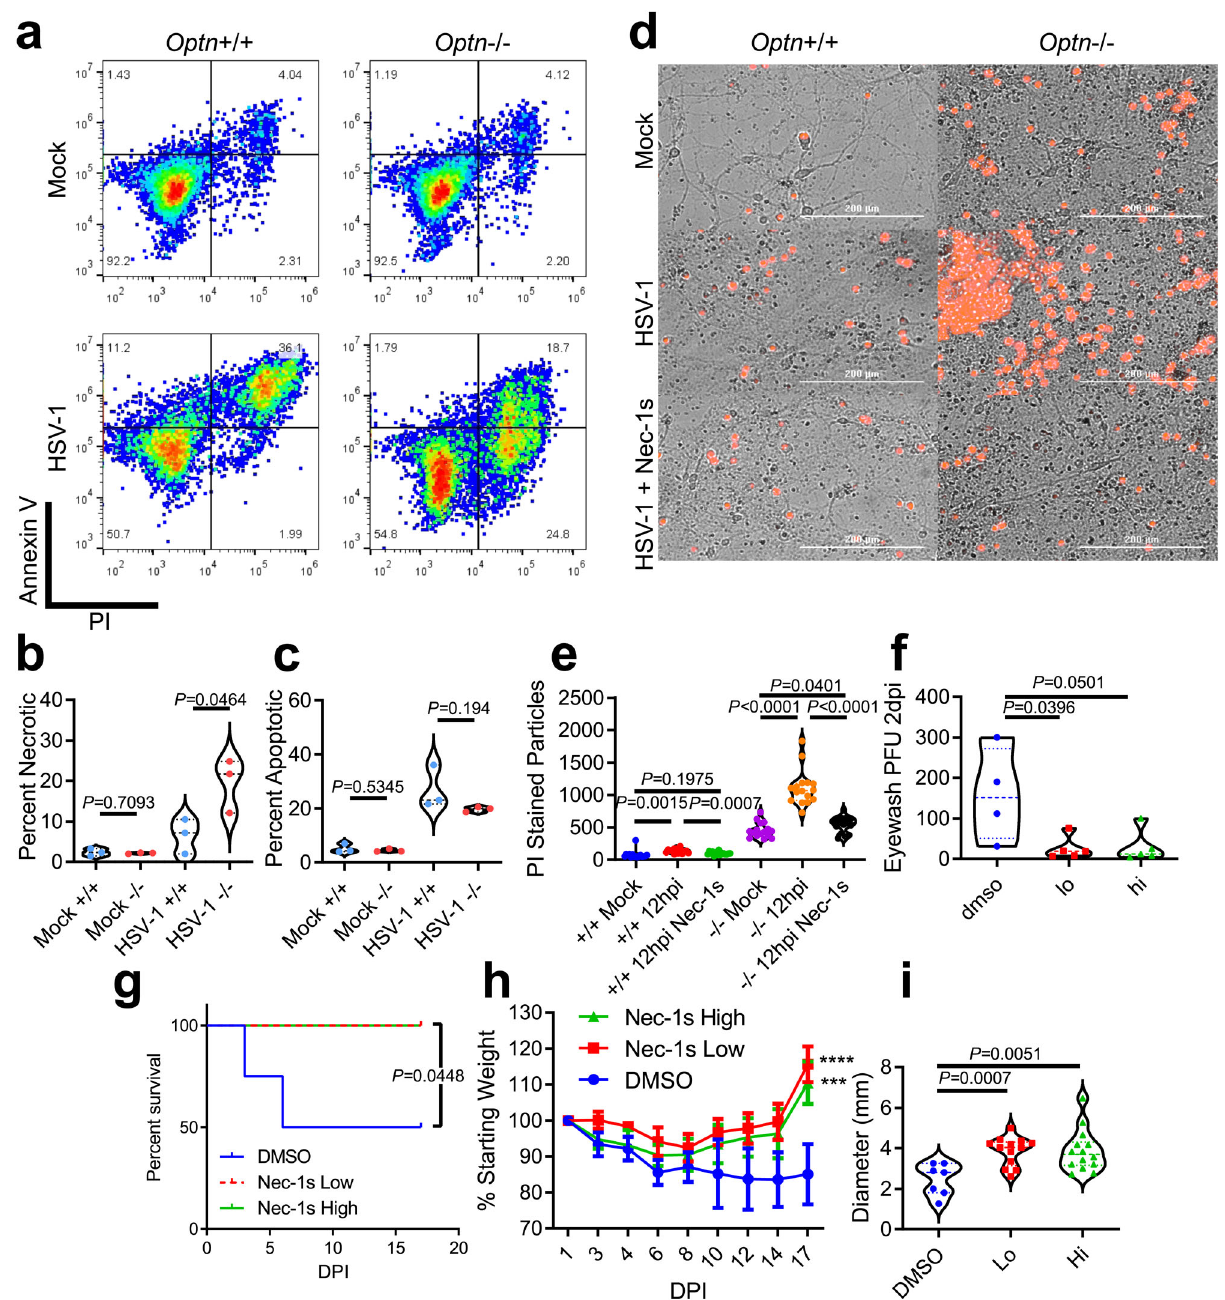
Fig. 7 OPTN suppresses necroptosis in vitro and in neurons during HSV-1 infection. a Dot plots of fl ow cytometry analysis of Optn + / + and − / − cells stained for Annexin V and propidium iodide (PI). b , c Percentage of ( b ) Annexin V lo, PI hi cells indicating necrotic cells or c Annexin V hi, PI hi cells indicating apoptotic cells. d Representative images of primary embryonic neurons from Optn + / + or − / − mice that were mock infected, HSV-1 infected, or HSV-1 infected and Nec-1s treated. Dead cells were stained using PI (Red). e Image quanti fi cation of PI-stained primary neurons. f – i Optn − / − were treated with hi Nec-1s ( n = 5 mice), lo Nec-1s ( n = 5 mice), or DMSO ( n = 4 mice) during infection. f Plaque assay on ocular washes from Optn − / − mice 2 dpi. g Kaplan – Meier curve for HSV-1 infected Optn − / − treated with DMSO, lo or hi Nec-1s. Logrank test for trend was used to compare curves with P < 0.05 being signi fi cant. h Percentage of initial weight over time. Two-way repeated-measures ANOVA F (16,88) = 1.758, p = 0.0503, multiple comparisons at 17 dpi (DMSO vs. Nec-1s Low) p < 0.0001, (DMSO vs. Nec-1s High) p = 0.0009. i dLN diameters for Optn − / − mice treated with DMSO, lo Nec-1s, or hi Nec- 1s at 17dpi and data are presented as mean values ± SEM. Unless otherwise stated Two-tailed Student ’ s t test was performed for statistical analysis ( α = 0.05). ∗ p < 0.05; ∗∗ p < 0.01; ∗∗∗ p < 0.001, ∗∗∗∗ p < 0.0001, ns not signi fi cant. Source data are provided as a Source Data fi Mouse infection experiments . The corneal scari fi cation method was used for epithelium with a 30-gauge needle, then mice were infected with 5× 10 5 PFU HSV- infection of mice. Mice were anesthetized using a mixture of ketamine and xyla- 1 by application of a virus containing solution to the corneal surface. For the novel zine, and the topical anesthetic, proparacaine, was applied to the ocular surface object recognition test mice were infected with 1× 10 5 PFU HSV-1 to reduced prior to epithelial debridement. Three parallel scratches were made in the corneal number of mice that reached endpoint criteria before 30 dpi. McKrae strain was